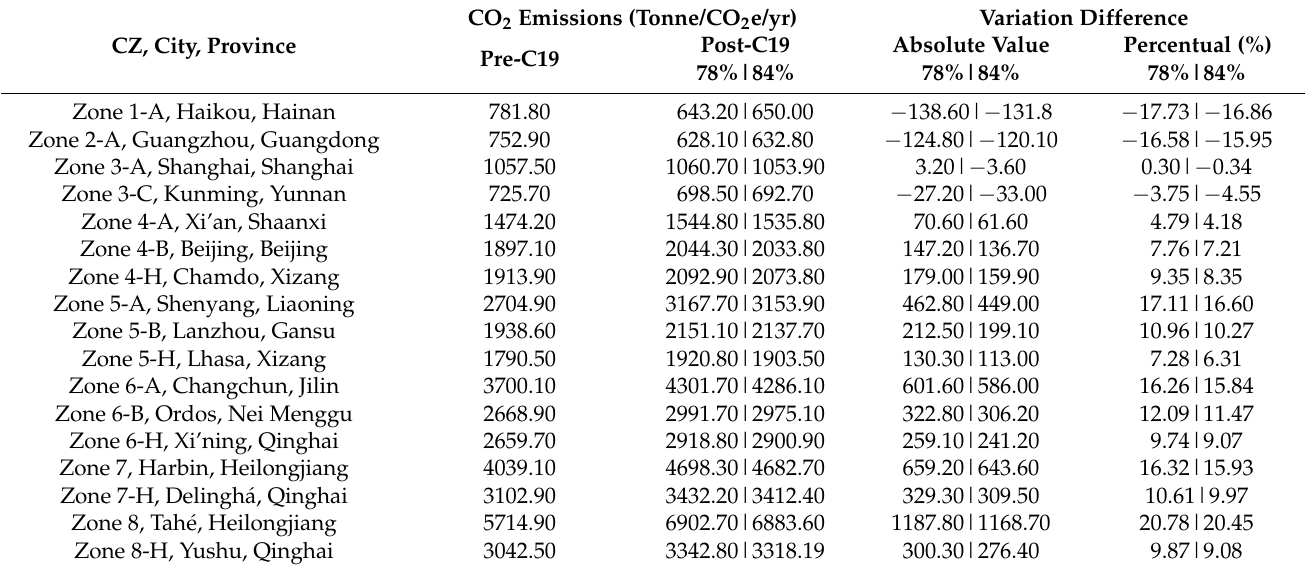
Table 12. CO 2 emissions per location in pre- and post-C19